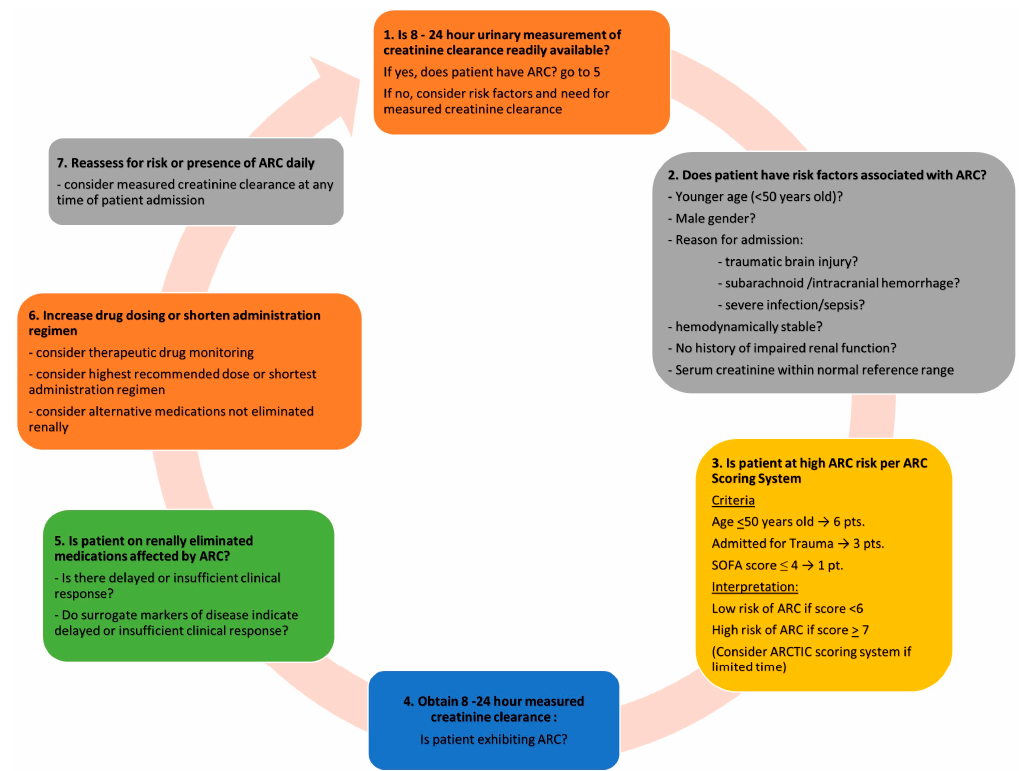
Figure 2. Assessment of ICU patients for augmented renal clearance (ARC).